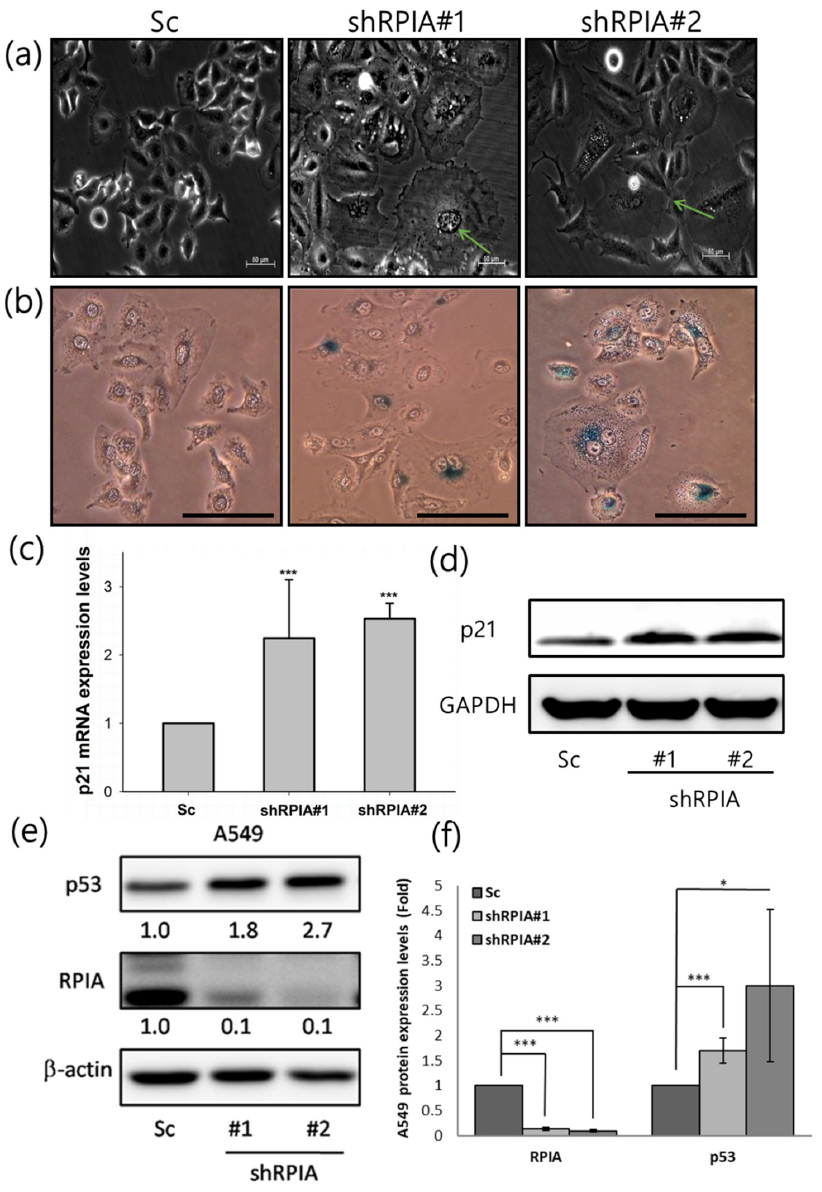
for apoptosis, the up-regulated LC3-II and down-regulated p62 levels for autophagy by the suppression of RPIA in A549 cells (Figure 8b). These data indicate that the knockdown of RPIA induces autophagy, apoptosis and cellular senescence mediated by rising ROS levels in lung cancer cells.